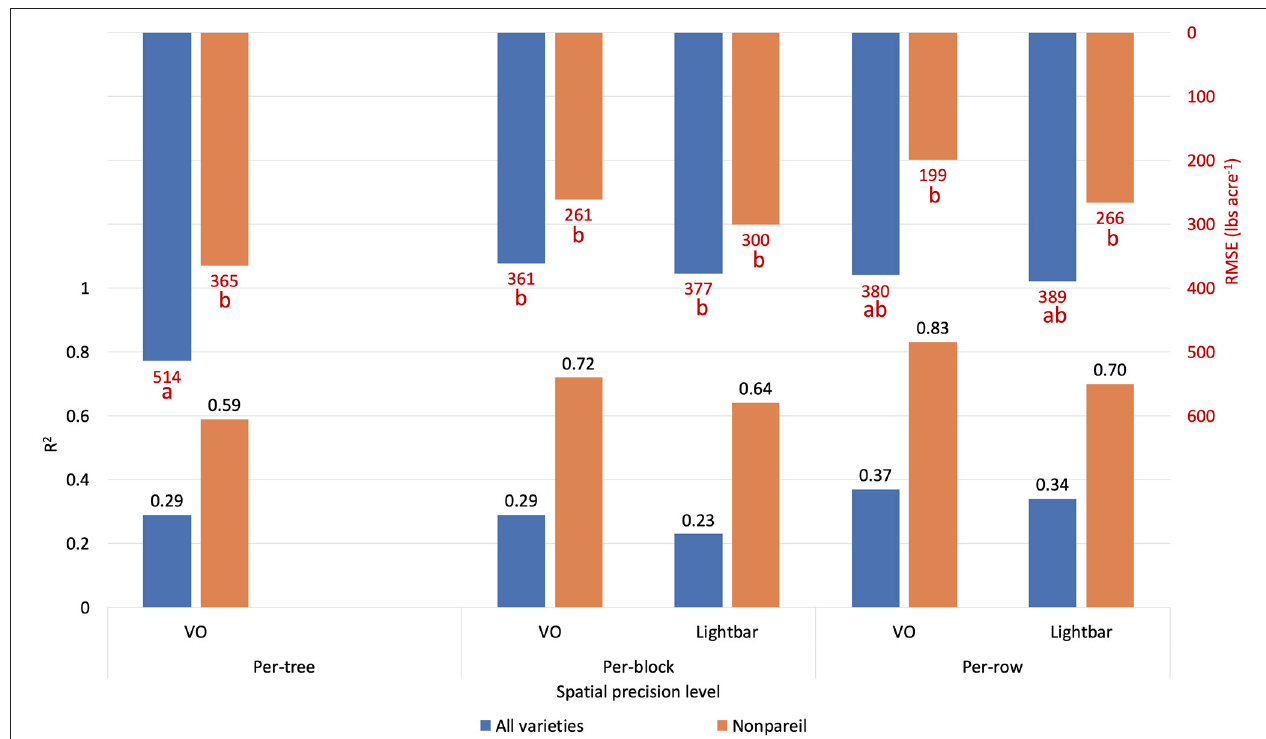
FIGURE 11 | Comparison of R 2 and root mean square error (RMSE) (to regression line) between fPAR Virtual Orchard (fractional PAR estimated by VO) and actual almond kernel yield for all varieties and ‘Nonpareil’ only at the per-tree, per-block, and per-row spatial precision levels. Both VO and lightbar data were collected on June 26. Different letters refer to a statistically significant difference testing the means of absolute errors in predicting actual almond yield with different regression models using analysis of variance (ANOVA) multi-comparison ( p <